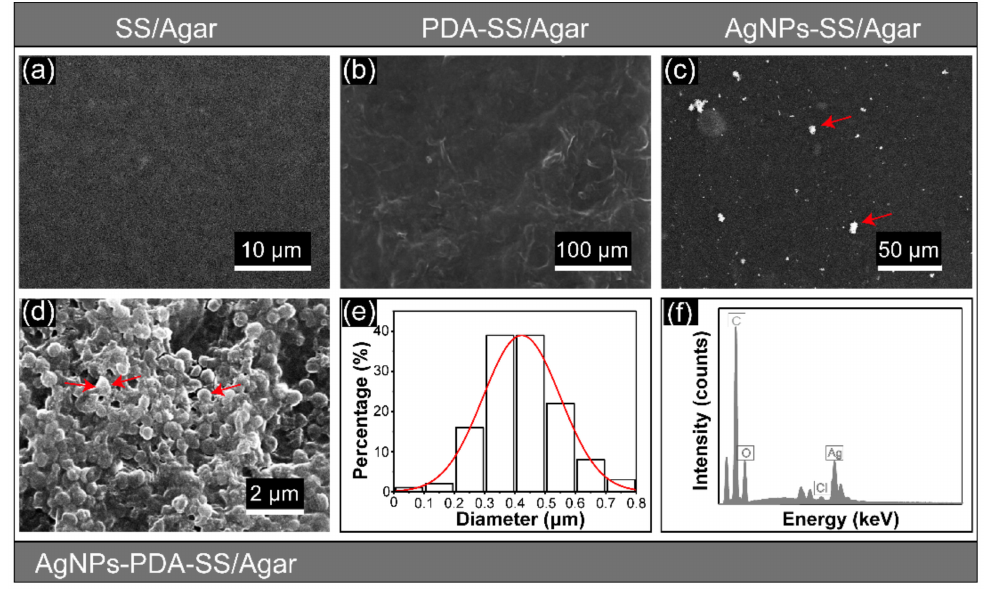
Figure 2. Surface morphologies of SS/Agar ( a ); PDA-SS/Agar ( b ); AgNPs-SS/Agar ( c ); AgNPs-PDA-SS/Agar films ( d ); ( e ) is the particle size analysis of ( d ); EDS spectrum of AgNPs-PDA-SS/Agar film ( f ). Red arrows indicate high-density